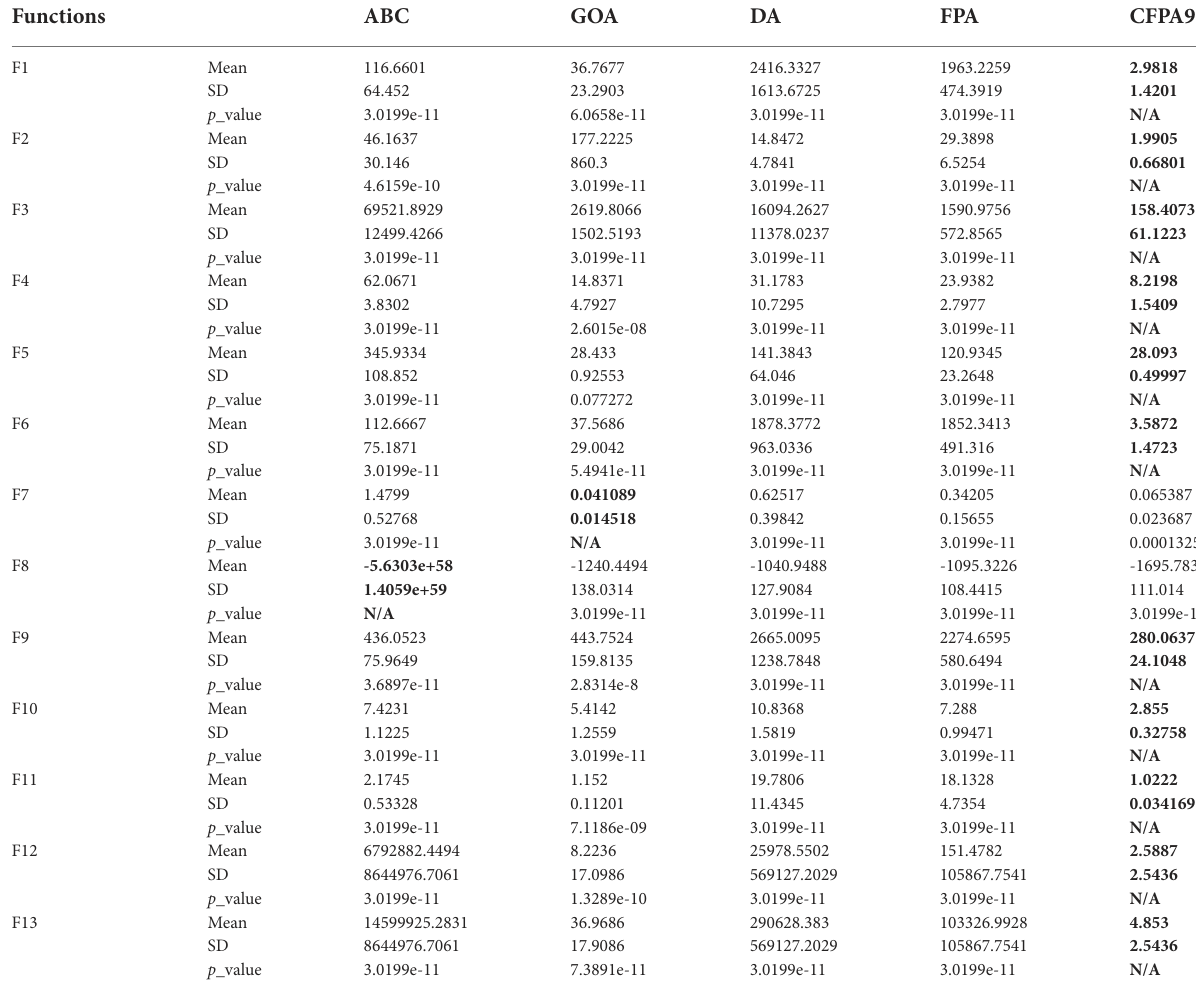
TABLE 7 FindingsofCFPA9vs.well-knownalgorithmsforbenchmarkfunctions.